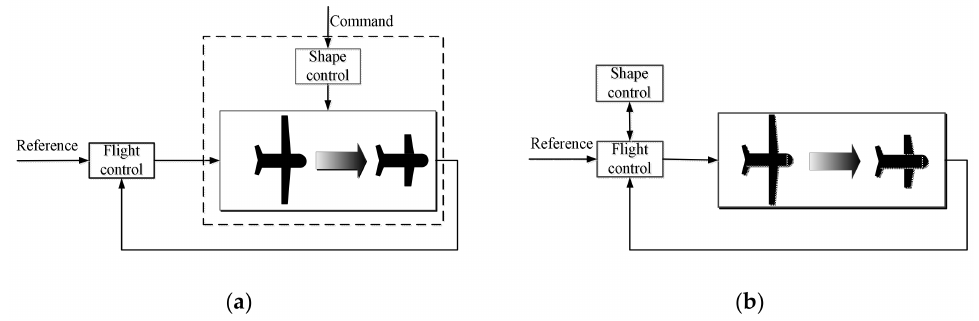
Figure 8. Different methods for flight control of morphing aircraft. ( a ) Independent shape and flight control and ( b ) integrated shape and flight